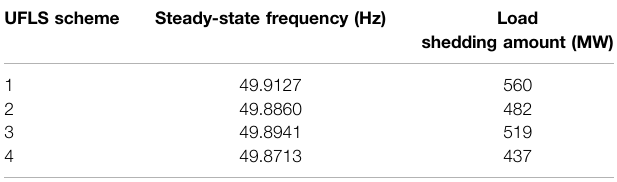
TABLE 1 | Results of different UFLS schemes considering different virtual inertia control modes.